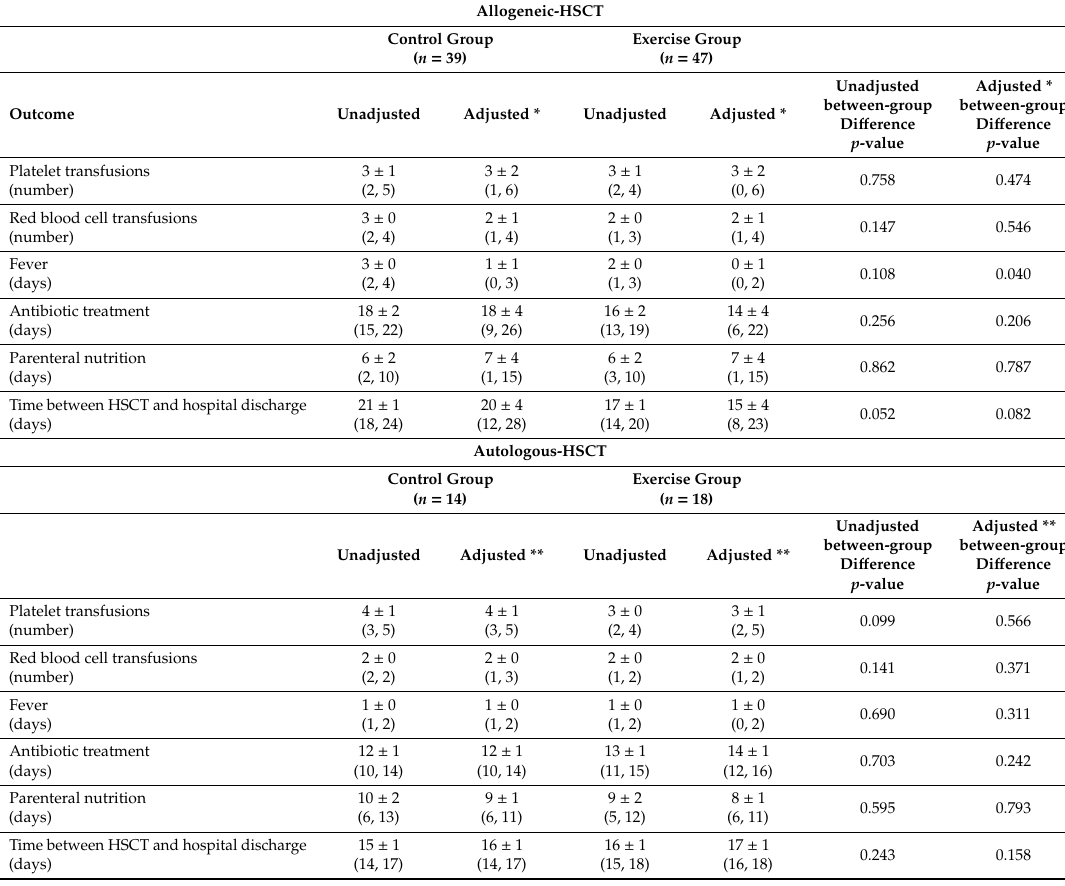
Table 4. E ff ects of exercise intervention on secondary outcomes (supportive